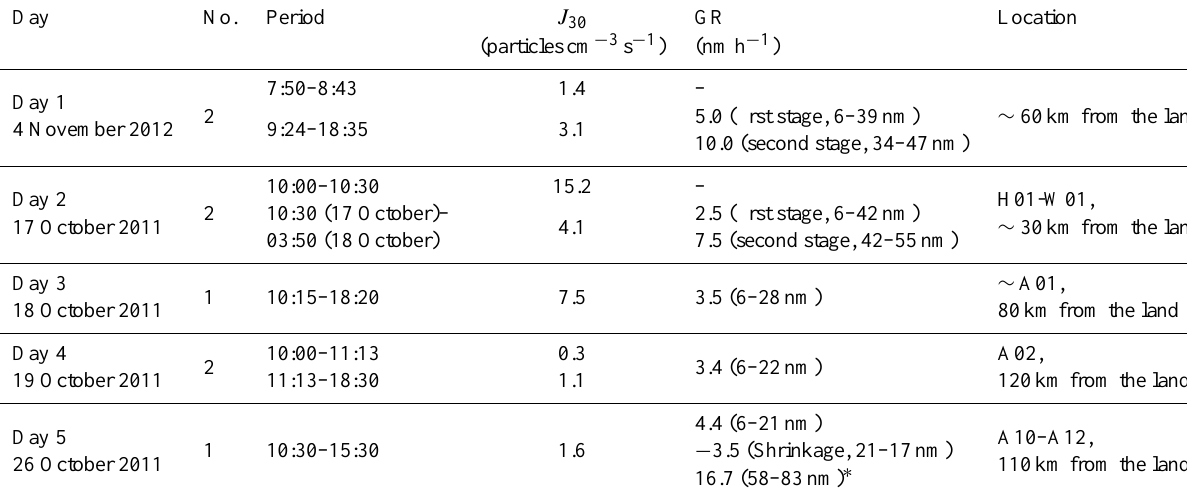
Table 1. Major characteristics of NPF events over marginal seas of China in the fall of 2011 and 2012.